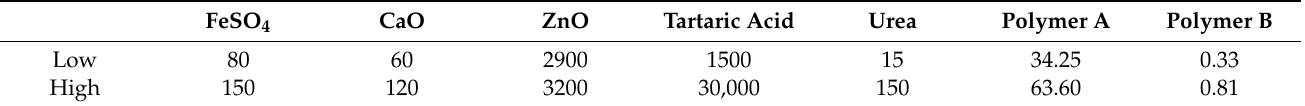
Table 3. Example flowback water composition from a shale gas well, USA (Marcellus Shale).